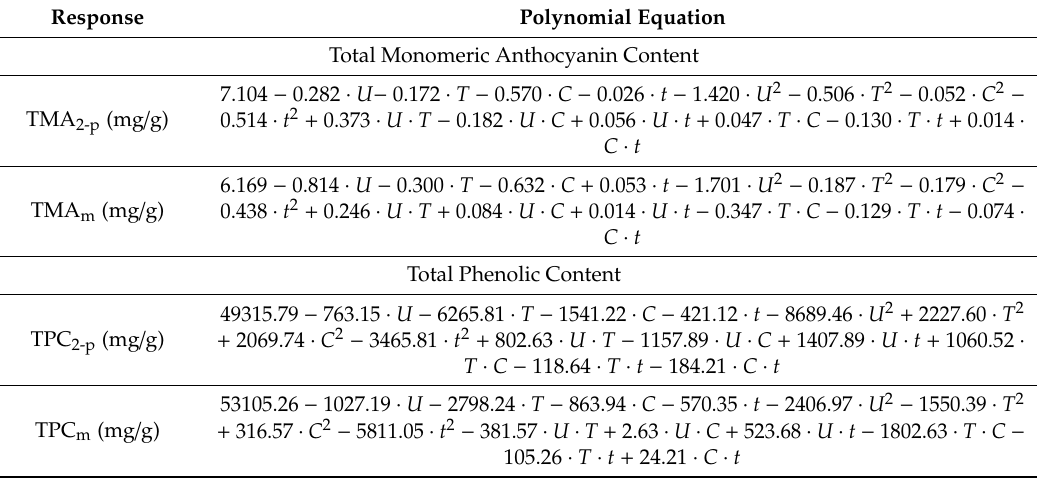
Table 5. Polynomial equations describing the e ff ect of the independent variables considered on the responses (TMA and TPC), for each extraction solvent (2-propanol and methanol). Response Polynomial Equation